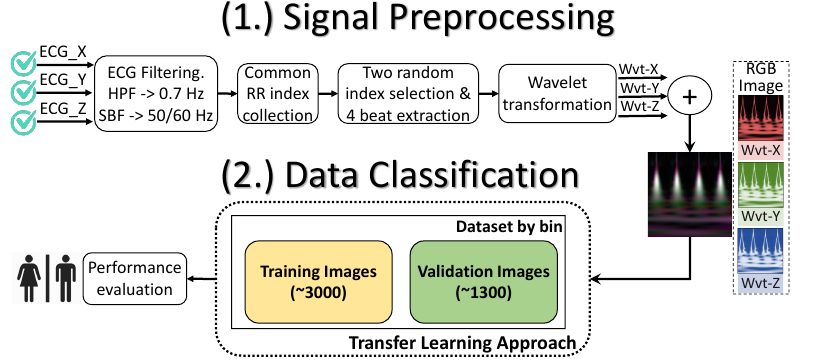
Figure 6. Research